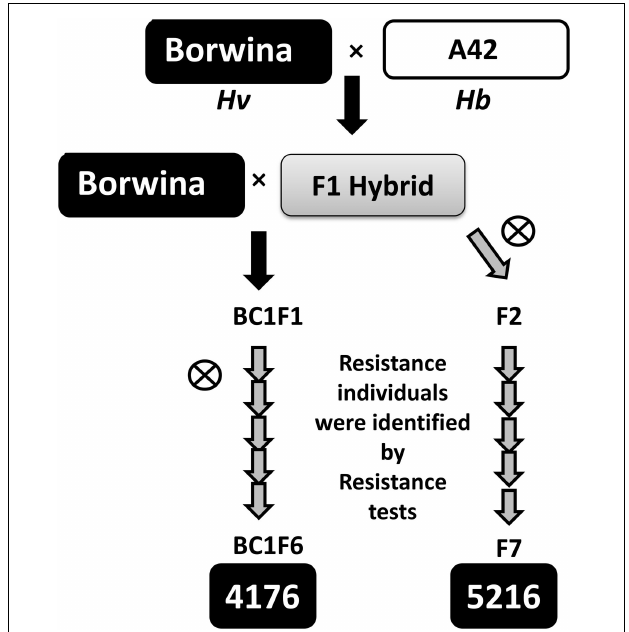
FIGURE 1 | Schematic outline of the mapping population design. The tetraploid Hb accession A42, resistant to the isolate CH4.8, was crossed to the tetraploid derivative of the susceptible barley cultivar “Borwina.” From tetraploid F1 hybrids, two different introgression mapping populations were developed: the “4176” population was developed by backcrossing the F1 hybrid once to the parent “Borwina,” followed by five generations of selfing. A gray arrow indicates a selfing generation. The “5216” population was derived from six generations of selfing from the F1 hybrid. In the course of development of populations “4176” and “5216,” the generations were diploid from BC1F2 and F2, respectively. Through the population development, each new selfing generation was obtained by selecting and selfing a single resistant heterozygous plant identified by resistance test with the powdery mildew isolate CH4.8 and marker data analysis, in order to promote